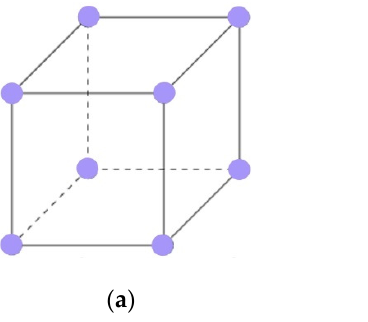
Figure 3. BCC with spheres. ( a ) Position of the centers of spheres; ( b ) Structure.